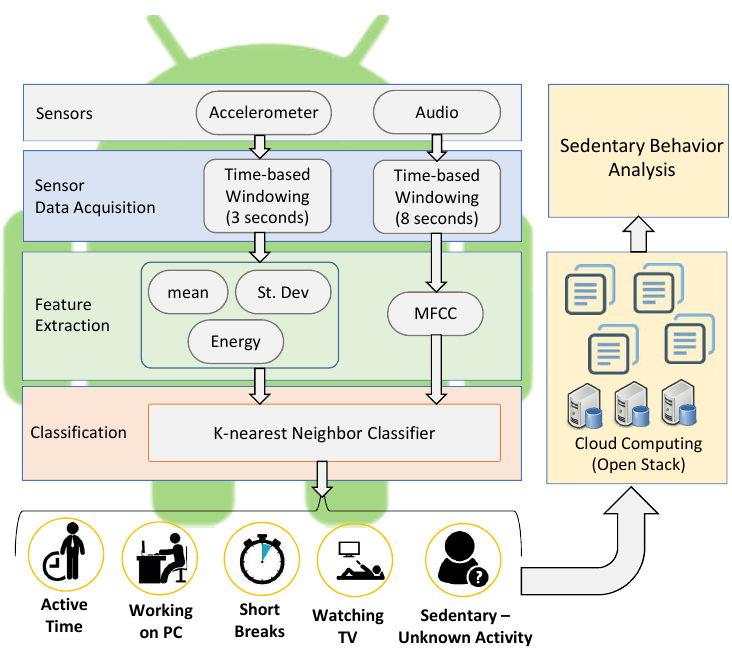
Figure 1. The proposed architecture of context mining. MFCC, Mel-Frequency Cepstral